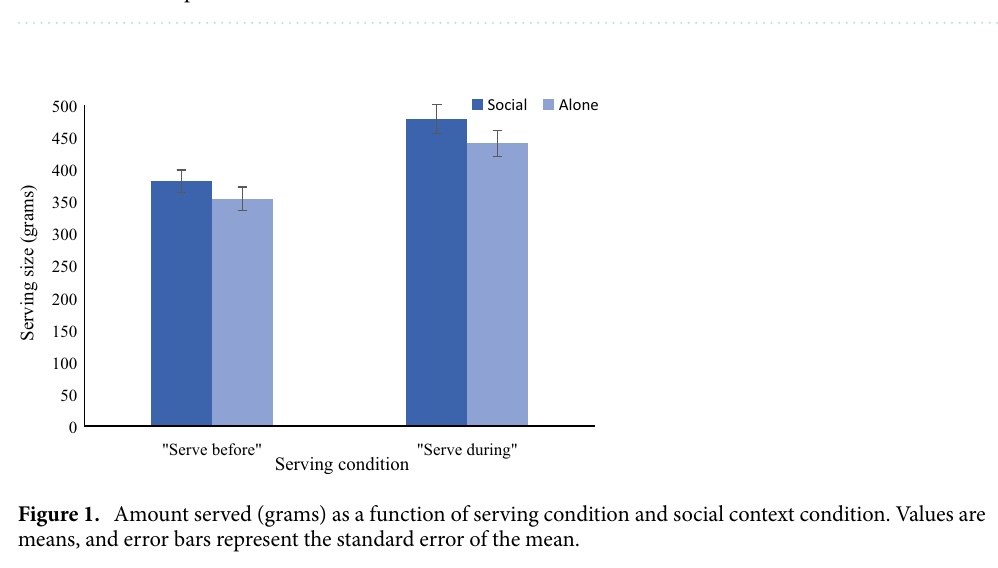
Table 1. Participant characteristics stratified by serving condition. Values are means (standard deviation). † Mean scores collapsed across social and alone conditions.